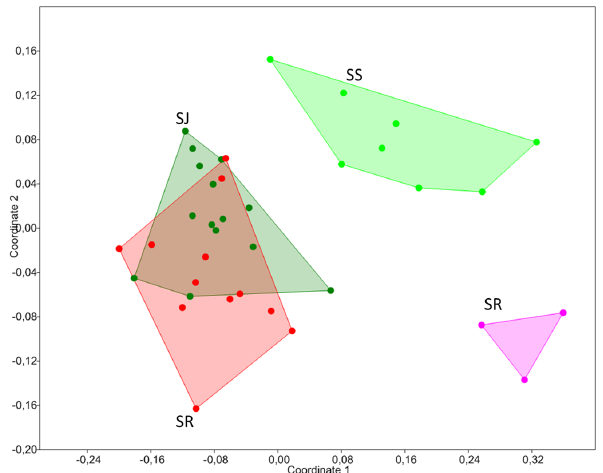
Figure 4. Non-metric multidimensional scaling, Euclidean dis- tances. Environmental parameters included in analysis: tempera- ture, total carbon, total nitrogen, water content, total microbial count of PCA and counts of Enterobacteriaceae. SS samples (3–10) in light green (sand or pumice with bird droppings), SJ samples (1– 7 and 10–15) in dark green (pure sand or pumice) and SR (1–12) samples in red (partly vegetated and non-vegetated area) and SR (15–17) in purple